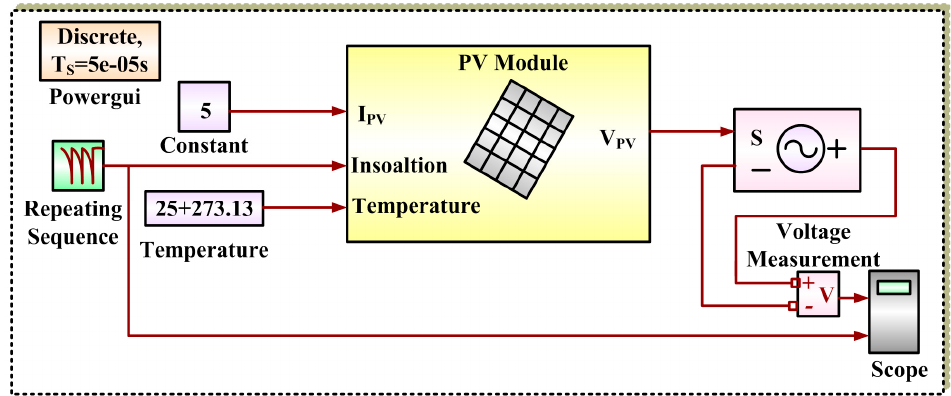
Figure 2. Simulink model of the PV module.